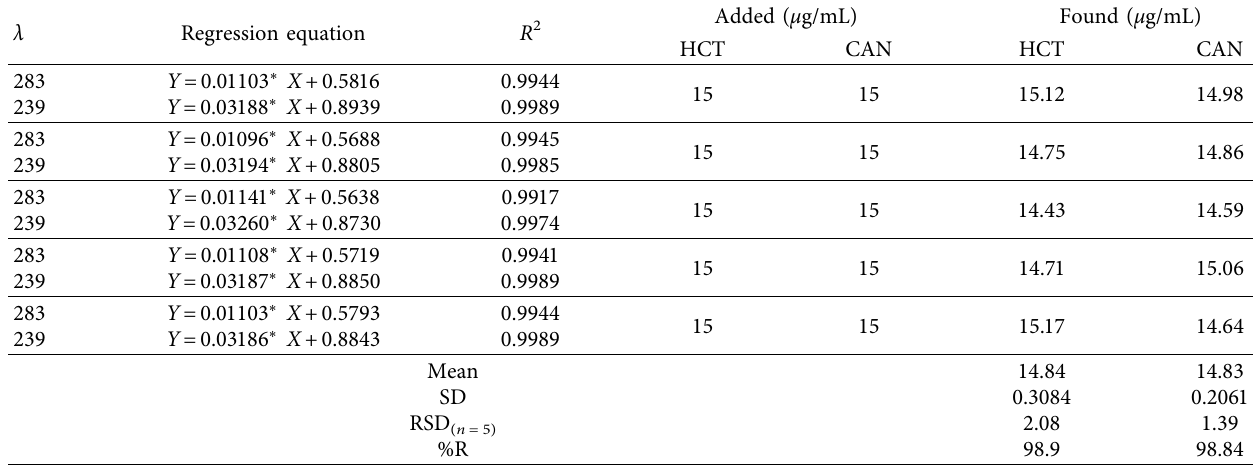
Table 10: Precision of the H -point standard addition method in the determination of HCT and CAN.